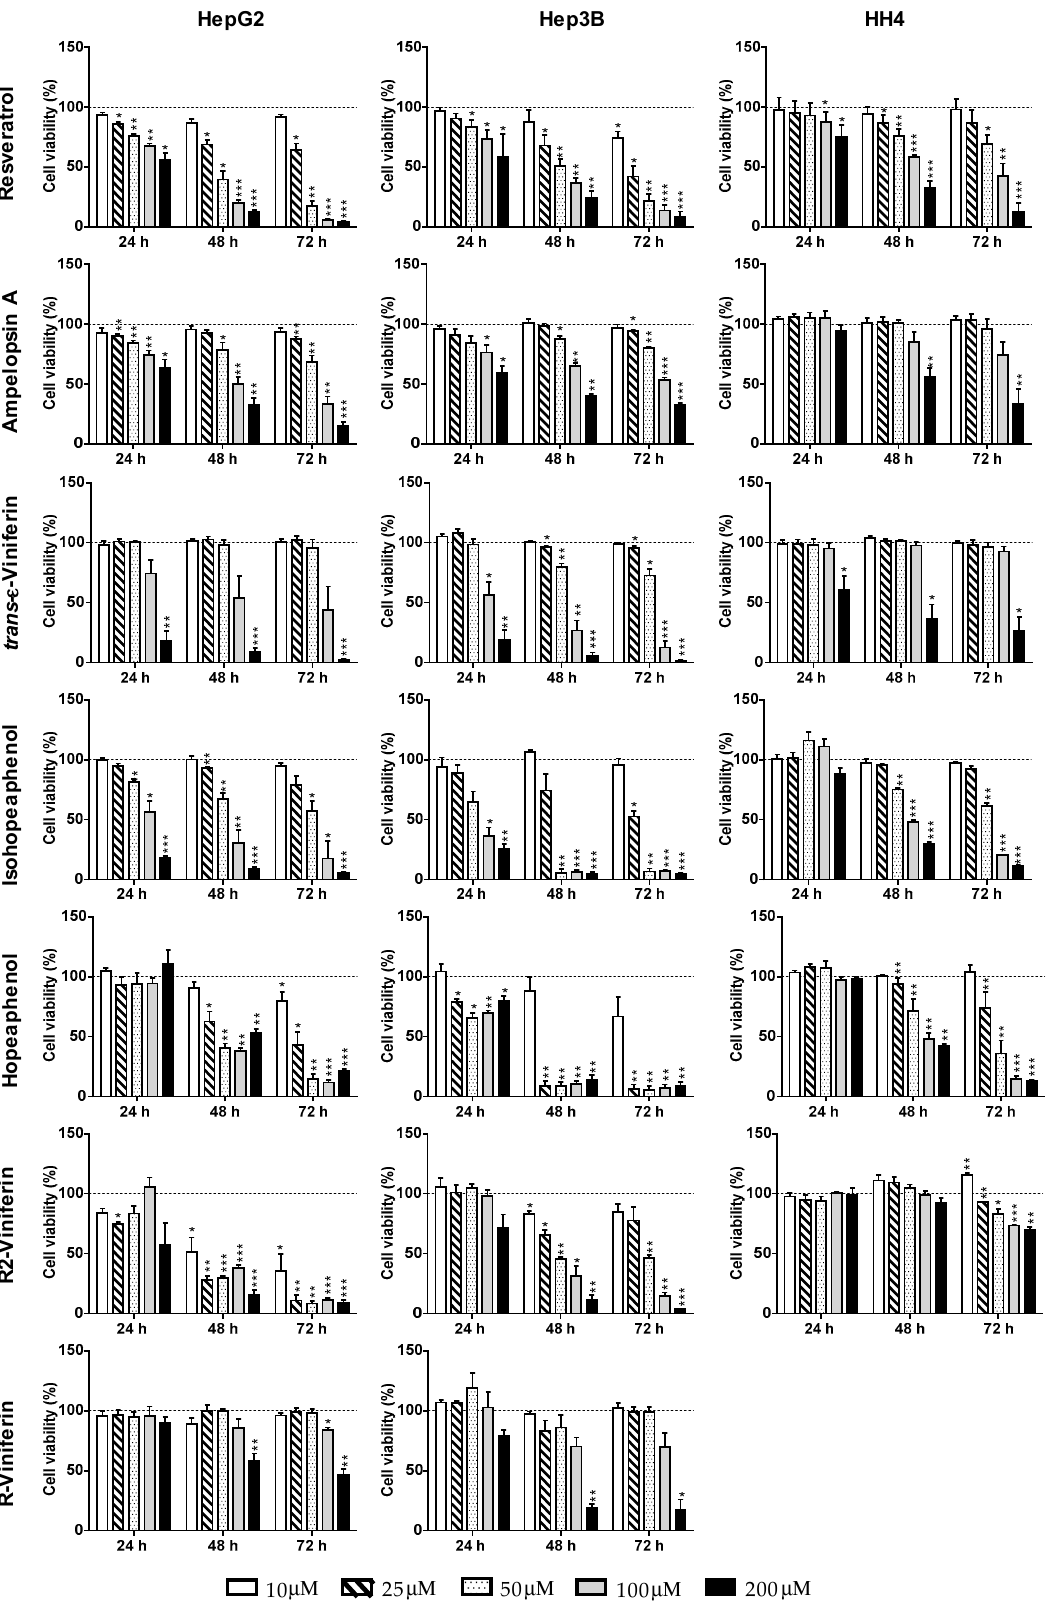
Figure 2. Effect of different stilbenoids on cell viability of HepG2, Hep3B and HH4. Cell viability was measured by crystal violet assay. Results are the mean + SE of n = 3–5 experiments. * p < 0.05, ** p < 0.01, *** p < 0.001, compared with control at the same time.